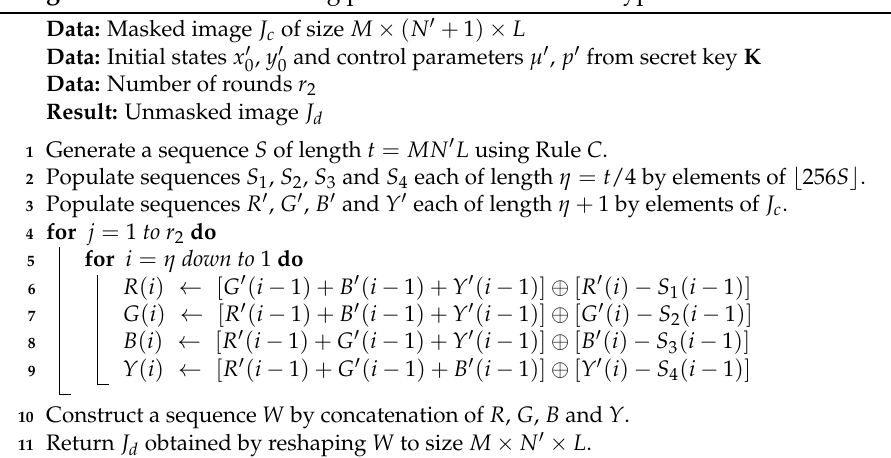
Algorithm 6: The unmasking phase of the lossless decryption